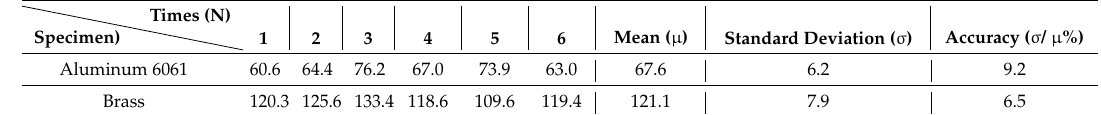
Table 3. Results of Young’s modulus (GPa) by tensile